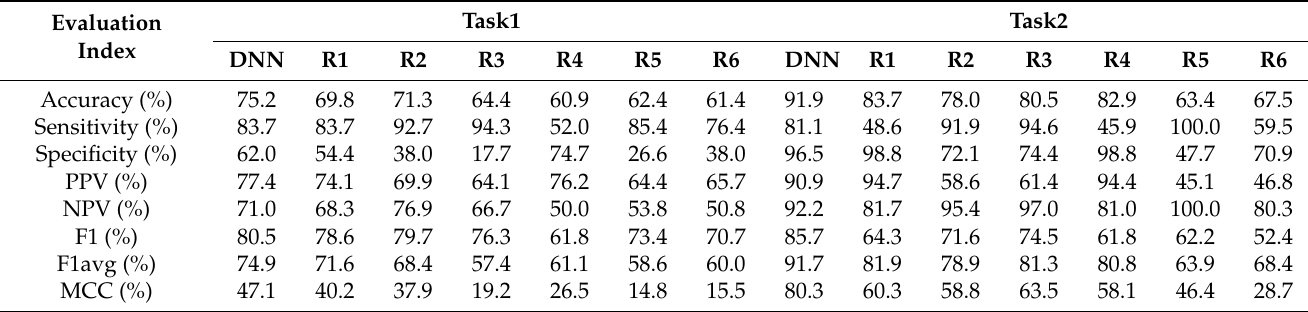
Figure 4. Bar plots of accuracy for DNN model and six readers performing Task1 and Task2, respectively. “Overall” denotes the accuracy of the overall dataset. “ ≤ 10 mm” denotes the accuracy for GGNs with a diameter smaller than 10 mm. “>10 mm” denotes the accuracy for GGNs with a diameter larger than 10 mm. ( a ) The accuracy of Task1. ( b ) The accuracy of Task2. Table 4. Performance comparisons of the proposed DNN and six readers by testing on validation dataset